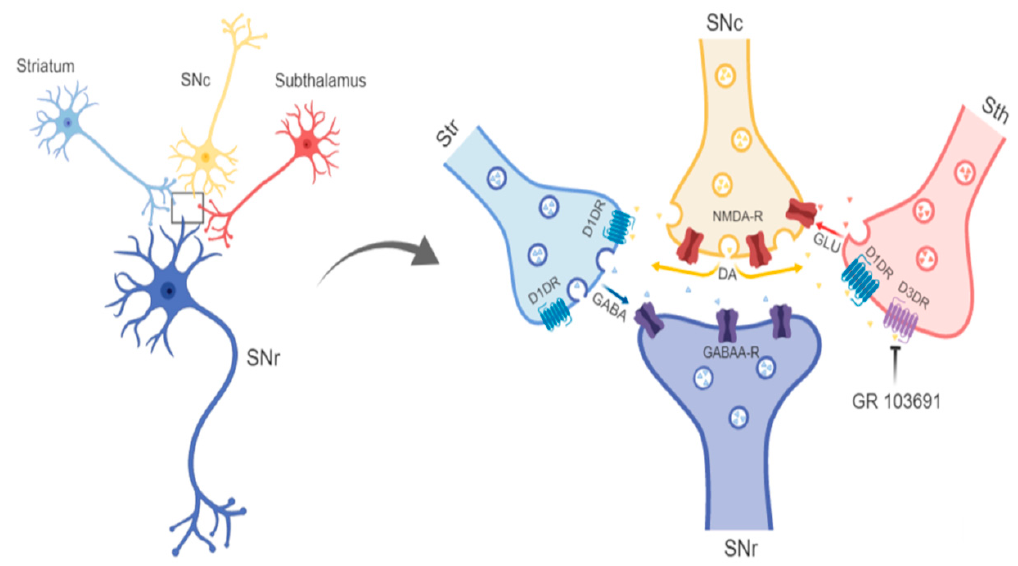
Figure 9. Drawing indicating intra-nigral local interaction among glutamate, dopamine, and GABA within the substantia nigra pars reticulata. The convergence of striatal, subthalamic, and nigra compacta dendrites on nigral output neurons is shown, as well as the presynaptic receptors participating in the interaction and the main site of the effect of the D3R antagonist. SNc, Substantia nigra pars compacta; Sth, subthalamic nucleus; DA, dopamine; GLU, glutamate.